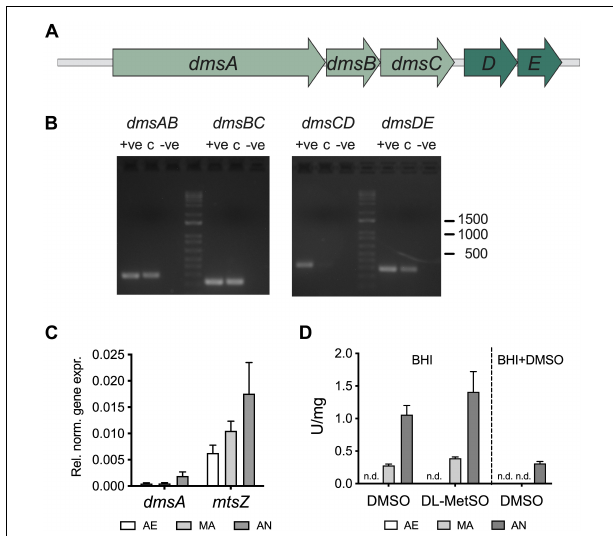
FIGURE 1 | Gene expression and biochemical activity of S-oxide reductases in Haemophilus influenzae . (A) Schematic representation of the H. influenzae dms operon (B) Co-transcription of dmsABCDE genes. Intergenic regions of adjacent genes were amplified using cDNA from Hi2019 cultures grown under anaerobic conditions as the template. +ve – positive control (gDNA), c – cDNA, –ve – negative control. (C) Expression of the dmsA and mtsZ genes in H. influenzae as a function of oxygen availability. Data are derived from qRT-PCR using RNA from Hi2019 cultures growing on CDM medium under aerobic (AE), microaerobic (MA), or anaerobic (AN) conditions; gene expression was normalized to 16S. (D) S-oxide reductase activity in cell extracts from Hi2019 cultures grown on BHI medium with or without DMSO added under AE, MA, or AN conditions. N.d. – not detected. The enzyme activity pattern matches the gene expression patterns and also reveals that DMSO reduces the expression of S-oxide reductases in H.